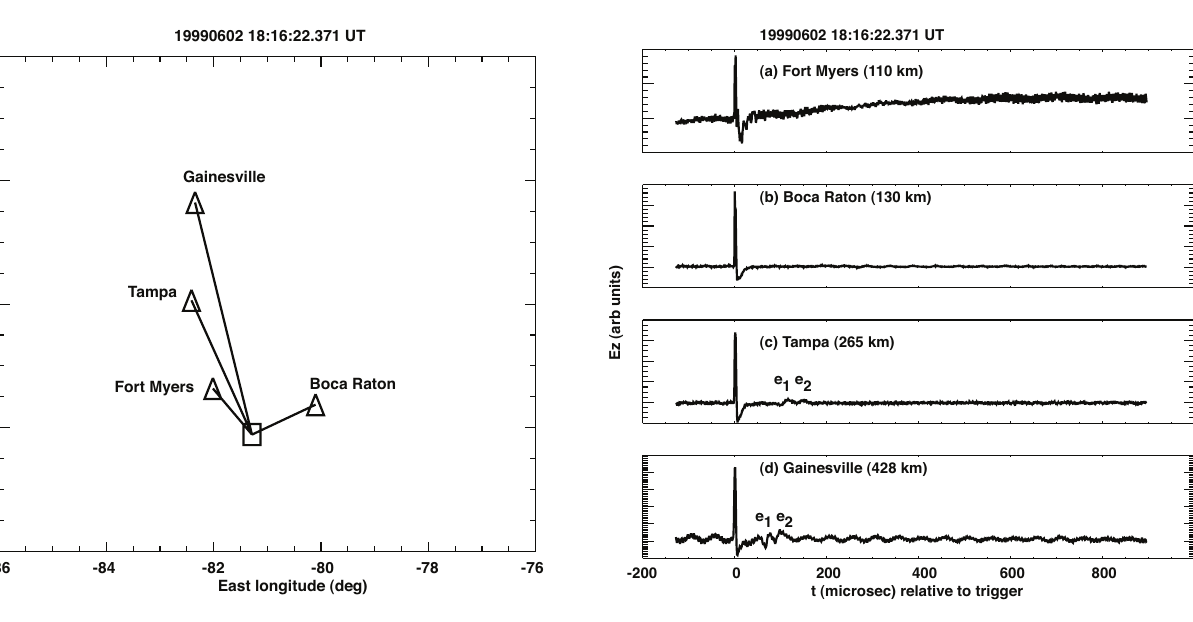
Fig. 3. Vertical electric field versus time (relative to each station’s trigger at t = 0), for the four LASA stations participating in the solution for the case of Fig. 2 above. The range of each station from the lightning is in parentheses. The Fort Myers station exhibits high-frequency electronic noise, while the Gainesville station has a narrowband noise ripple. The two echoes from the ionosphere are marked, and their relative amplitudes and delays from the ground wave are as is expected due to the reflection geometry. These two features of the echoes – increasing relative amplitude with increas- ing range, and decreasing delay with increasing range – are both outcomes of the ionospheric reflections